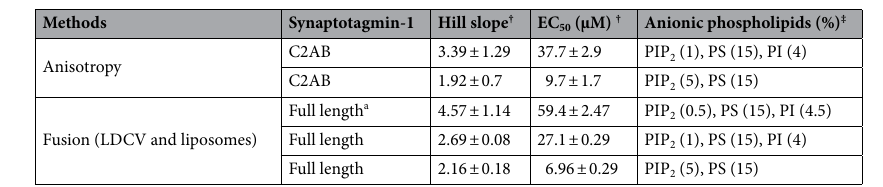
Table 2. Hill slope and EC 50 of Ca 2+ dose–response curve. † Hill slope and EC 50 of Ca 2+ dose–response curve were calculated using four-parameter logistic equations in GraphPad Prism. Data in the table are means ± SE (standard error) from three to five independent experiments. All experiments were carried out in buffer containing 3 mM ATP and 1 mM MgCl 2 (section “Material and methods”). ‡ Lipid compositions of